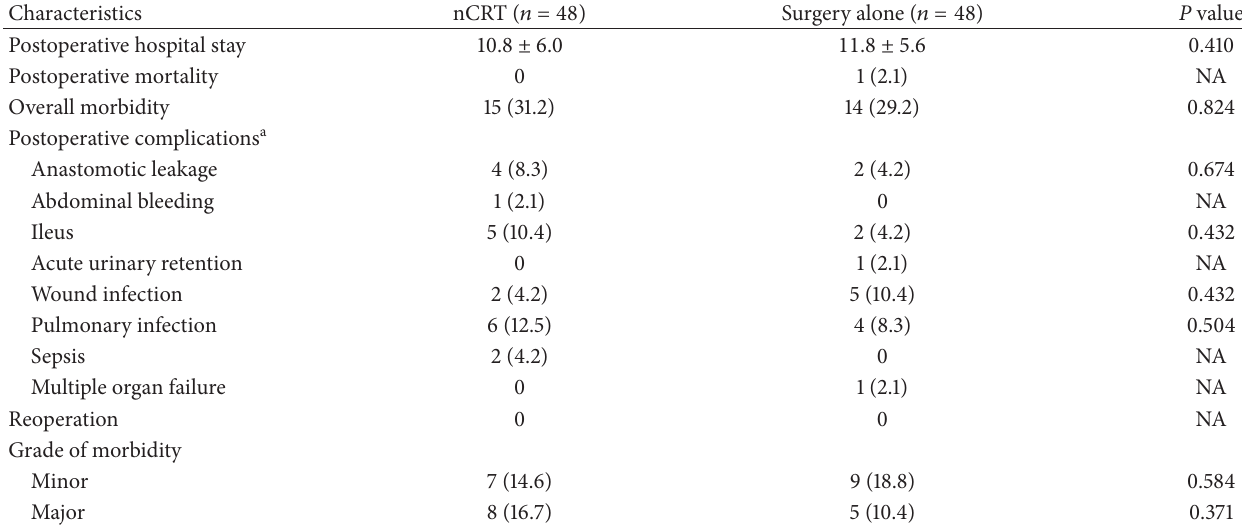
Table 3: Postoperative morbidity between nCRT and surgery-alone groups.